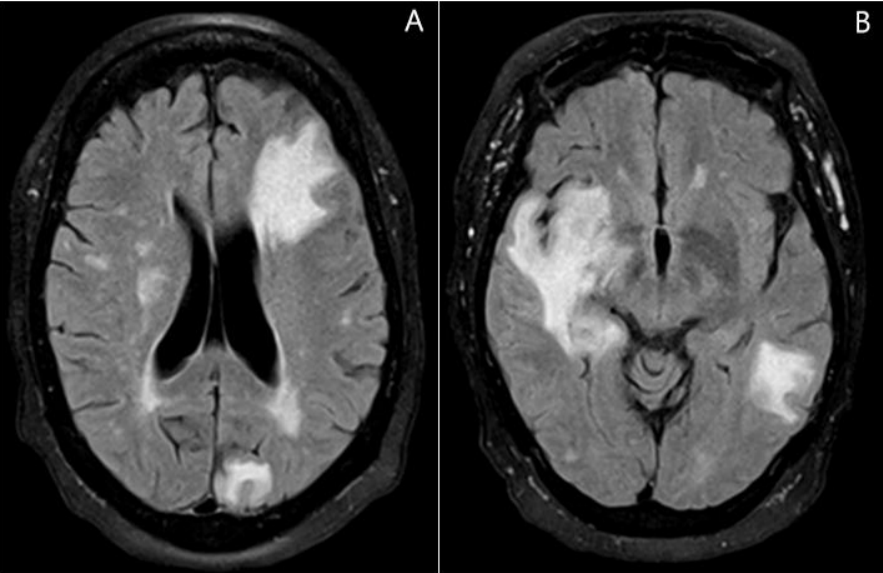
Figure 2. ( A ) Axial MRI FLAIR image demonstrating a hyperintense signal in the left frontal region left occipital and changes in a patchy manner occurring bilaterally. ( B ) There is a vasogenic edema and mass effect within the anterior right temporal lobe and a posterior left temporal lobe involving the left temporal stem and mesial temporal lobe.